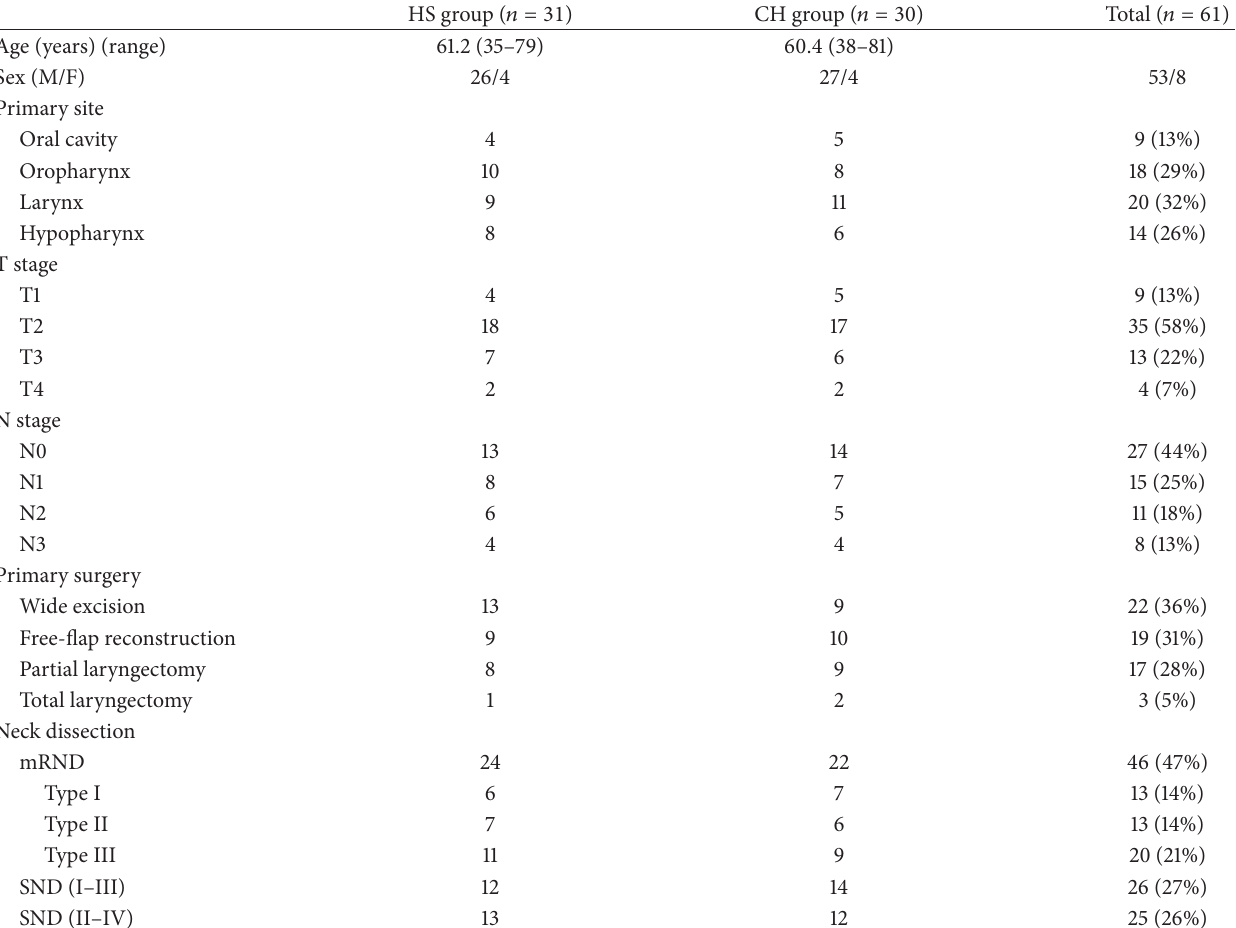
Figure 1: Focus Ultracision harmonic scalpel (Ethicon Endo-Surgery, Inc., Cincinnati, Ohio). The curved blade and the clamp arm with teflon pad of the Focus Ultracision harmonic scalpel used in otolaryngologic surgery. Table 1: Demographic characteristics, stage of the tumour, and type of surgical procedure in harmonic scalpel (HS) and conventional hemostasis (CH)